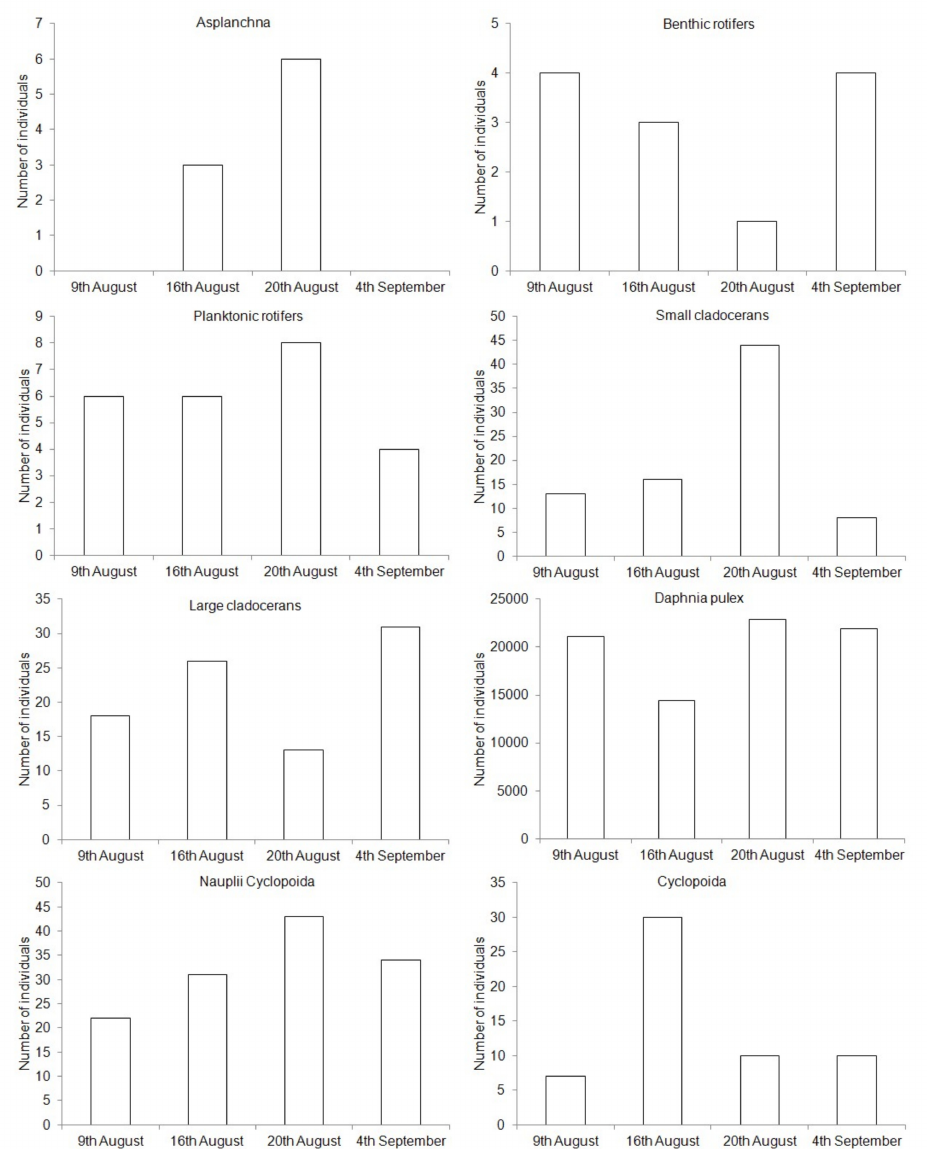
Figure 3. Total number of zooplankton individuals in stomachs of total